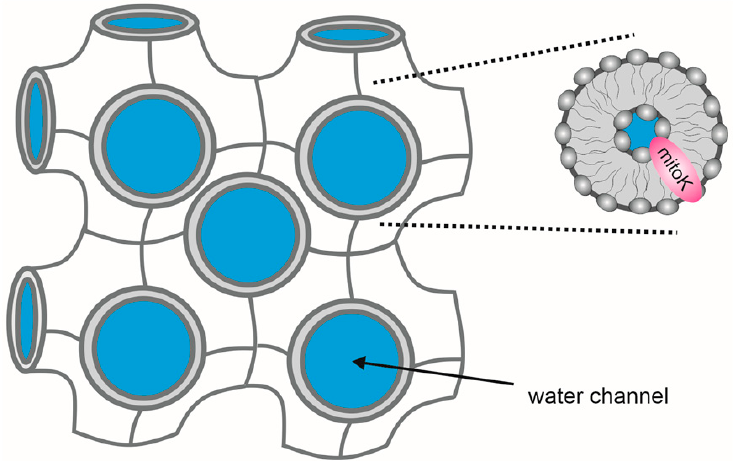
Figure 4. The lipidic liquid crystalline cubic phase (LLC) includes a curved bicontinuous lipid bilayer extending in three dimensions and surrounds two interpenetrating but noncontacting aqueous nanochannels. This double-diamond cubic phase with Pn3m space group shown above is promising for stabilizing membrane proteins and studying their function. Mitochondrial potassium channels could be embedded in the LLC, with their hydrophobic domains incorporated in the lipid bilayer and extramembranous domains exposed to aqueous channels.